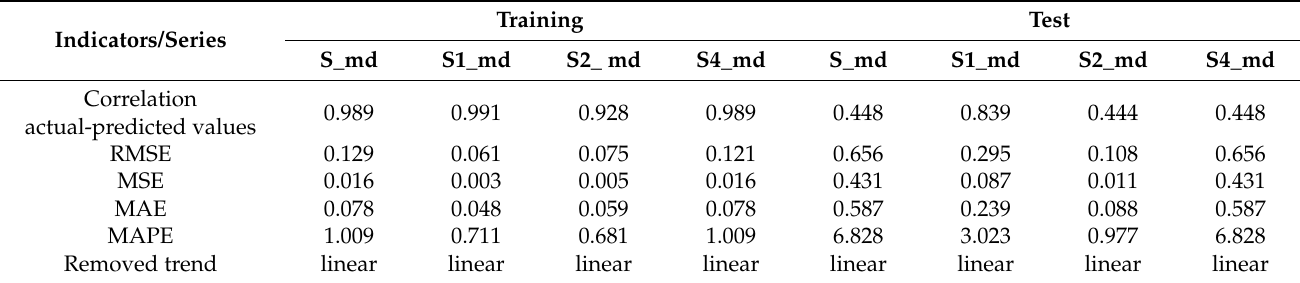
Table 8. Performances of the best models built for the detrended monthly series and subseries with lag 1 and lag 12 variables as regressors. Indicators/Series